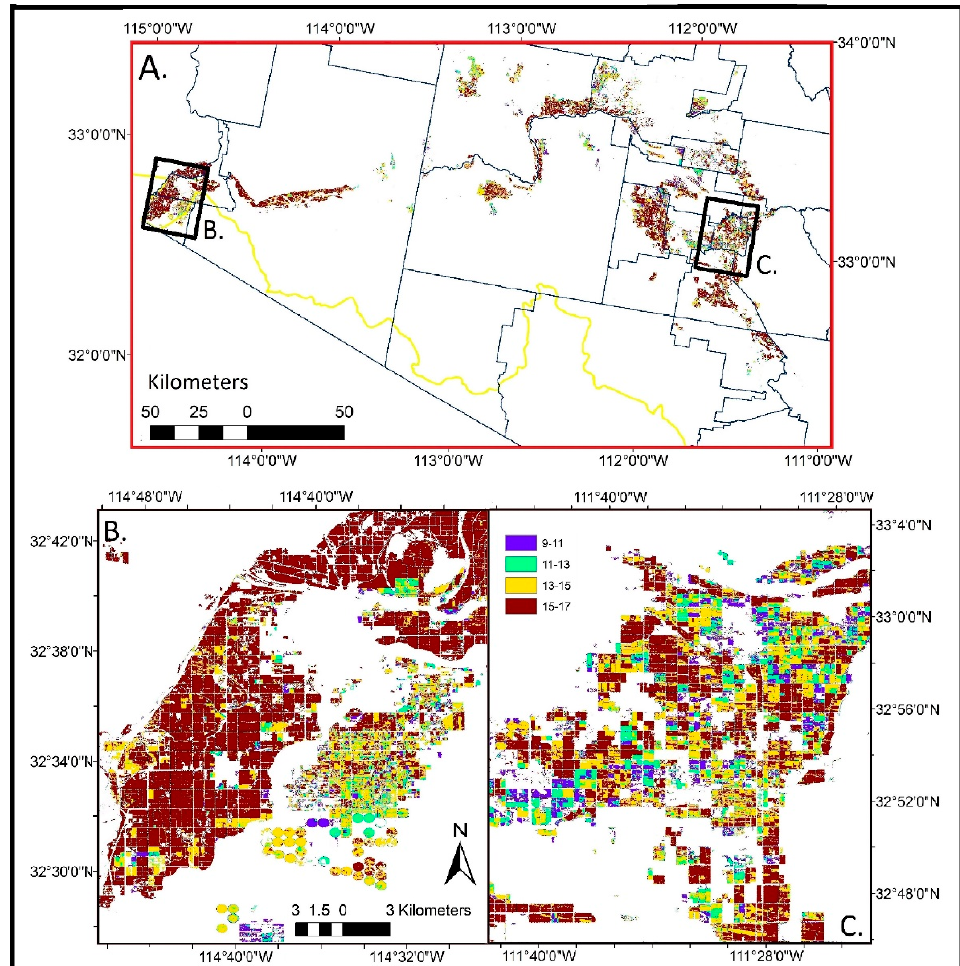
Figure 3. Total number of years croplands remained in active production for the full LCRP and PPAMA study areas ( A ); an example region within LCRP ( B ); and an example region within PPAMA ( C ).